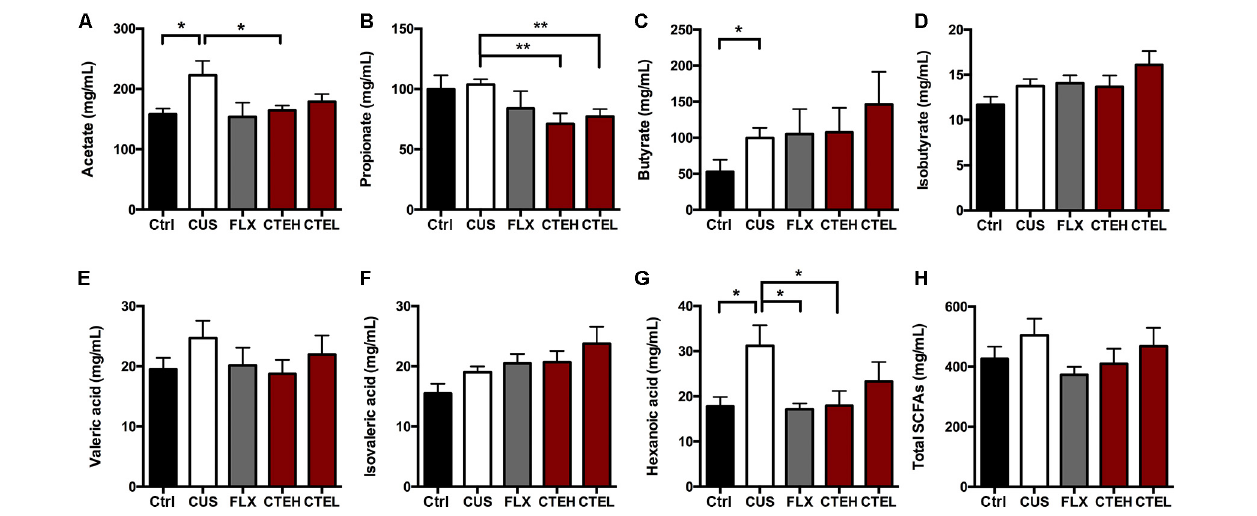
FIGURE 6 | The changes of SCFAs in fecal samples of CUS rats treated with CTE: (A) acetate, (B) propionate, (C) butyrate, (D) isobutyrate, (E) valeric acid, (F) isovaleric acid, (G) hexanoic acid, and (H) total SCFAs. Ctrl, control; CUS, chronic unpredictable stress; FLX, fluoxetine; CTEH, C. tubulosa extract high dose; CTEL,